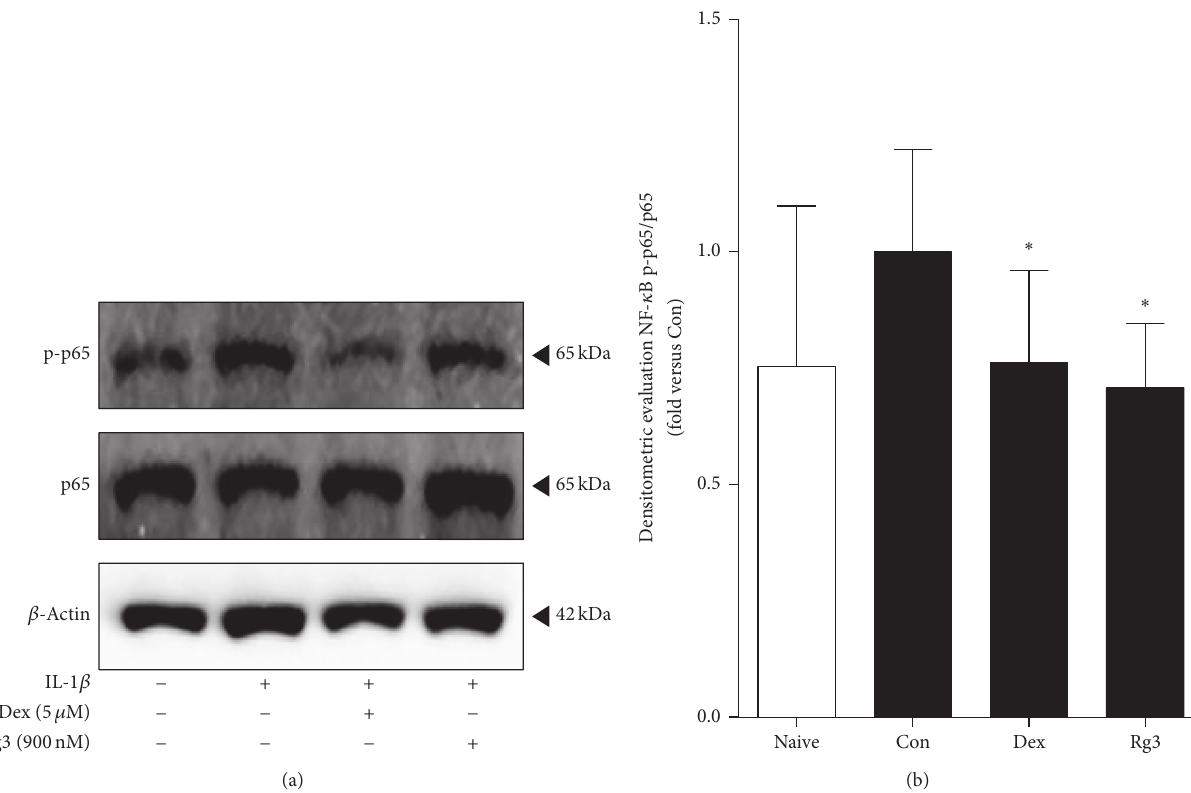
Figure 2: Effects of Rg3 on NF- 𝜅 B pathway in IL-1 𝛽 -induced inflamed A549 cells. (a) The western blot results in representative three separate experiments. (b) Ratio of phospho-p65/p65 expression was measured by Image J program. Statistical significance was determined by unpaired 𝑡 -test (one-tail) compared to Con. Values are means ± SEM. ∗ 𝑃 < 0.05. Naive: normal condition; Con: IL-1 𝛽 treated A549